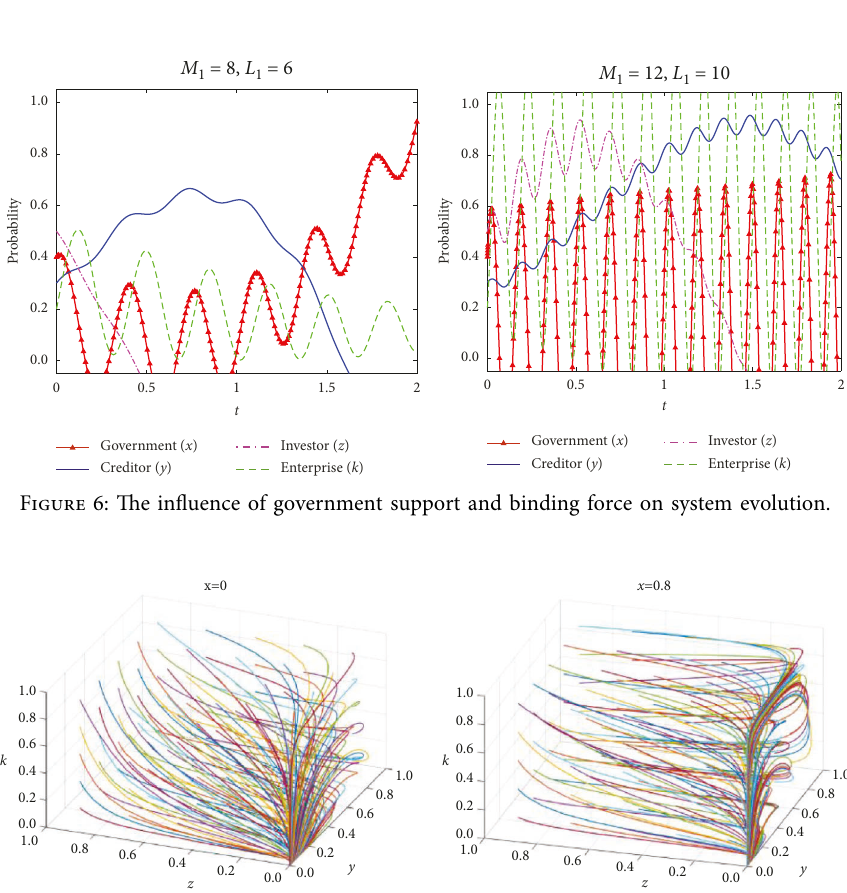
Figure 7: The impact of government support mechanisms on system evolution.